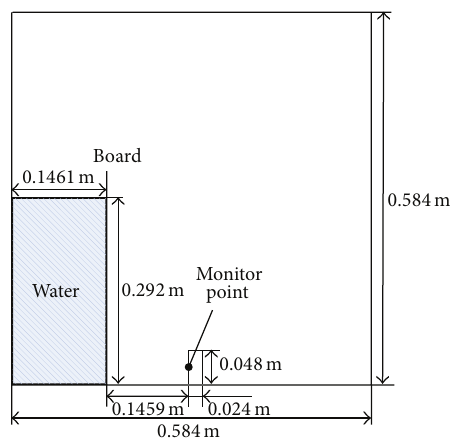
Figure 8: Computational domain.